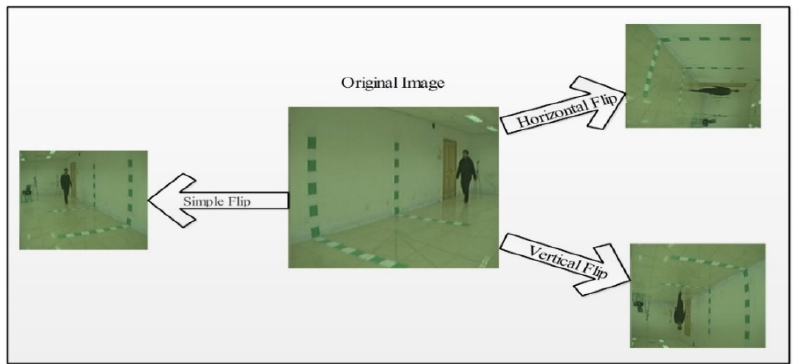
Figure 3. Output of the data augmentation step.